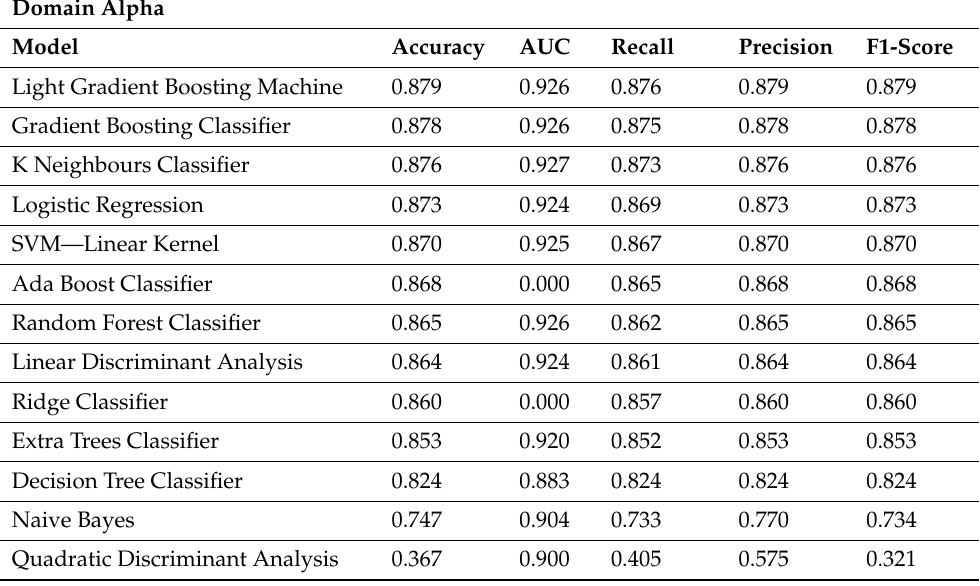
Table 1. The best model for the Domain Alpha.